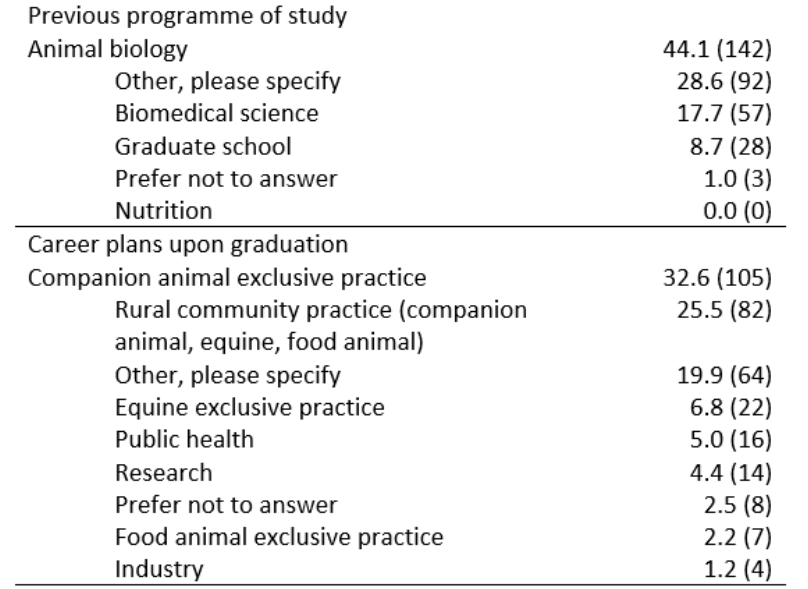
Table 1. Previous programme of study and career plans upon graduation of first year Canadian and US veterinary students who completed questionnaire on nutrition attitudes and behaviours